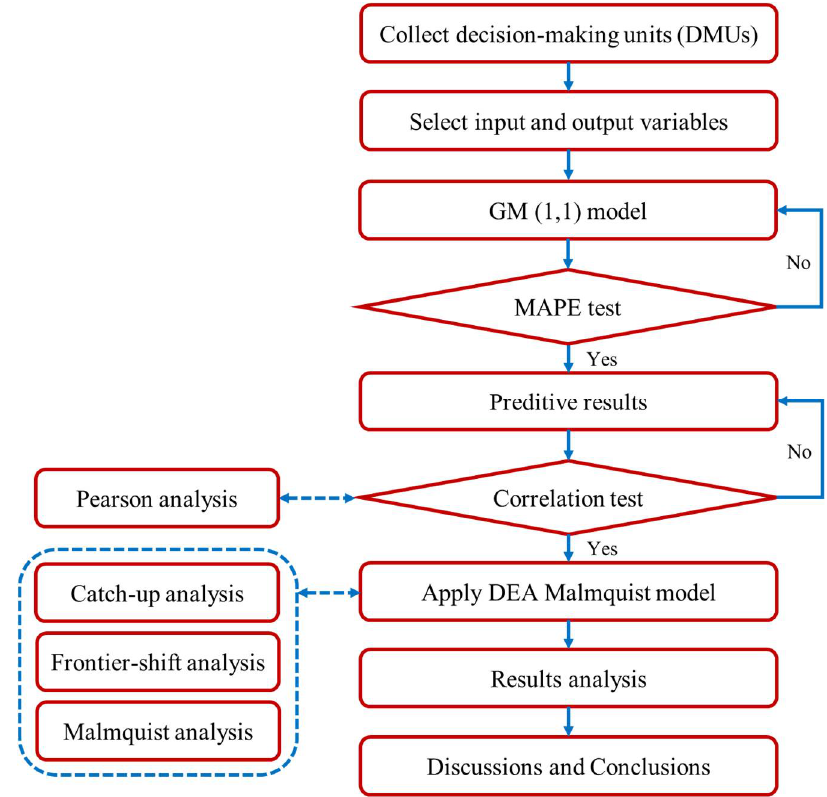
Figure 1. Research process.